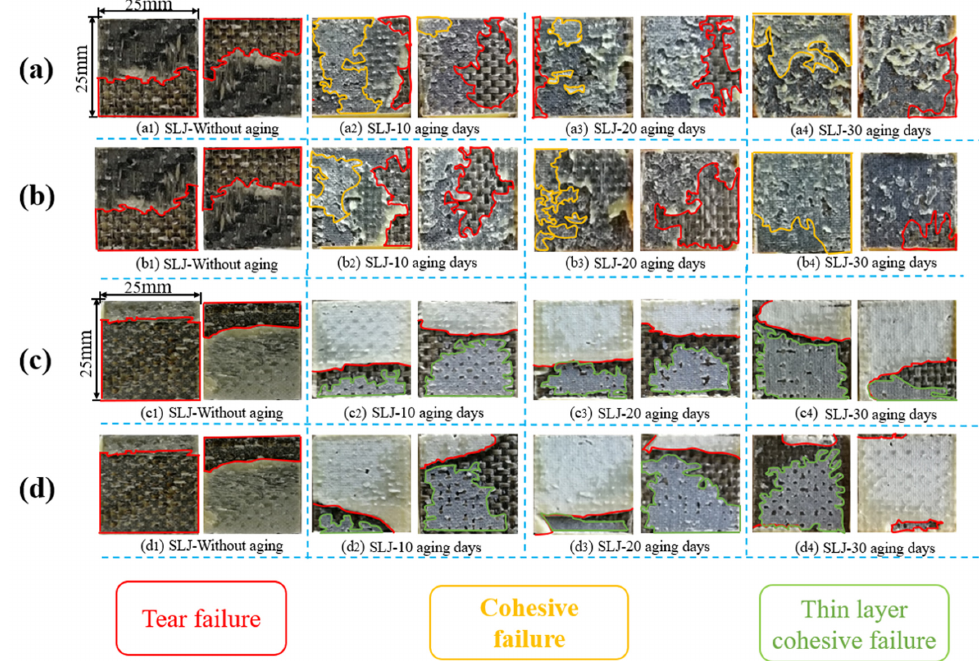
Figure 12. ( a ) The surface of A2012 joints in 80 ◦ C/95% RH; ( b )the surface of A2012 joints in 80 ◦ C/pure water; ( c ) the surface of A2015 joints in 80 ◦ C/95% RH; ( d ) the surface of A2015 joints in 80 ◦ C/pure